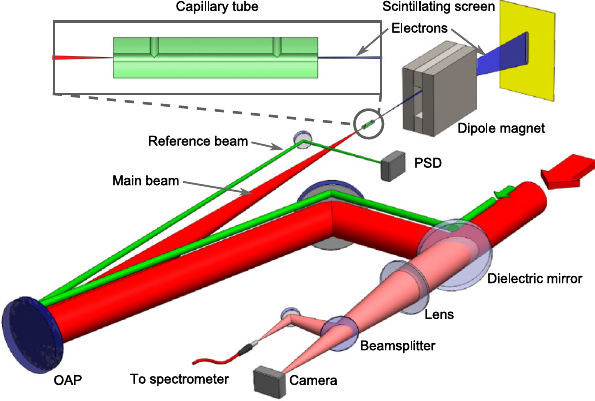
FIG. 1. Sketch of the experimental setup. The main laser pulse (red) is focused by an off-axis parabolic mirror (OAP) into a dielectric capillary tube (or a gas jet) filled with hydrogen gas. The accelerated electrons are dispersed by a dipole magnet before reaching a scintillating screen. The leakage from a dielectric mirror in the beam path is used to record spatial and spectral intensity distributions of every laser pulse. A continuous refer- ence beam (marked in green for clarity, but in reality of the same wavelength as the main beam) is used in combination with a position sensitive detector (PSD) for feedback to a system for active pointing